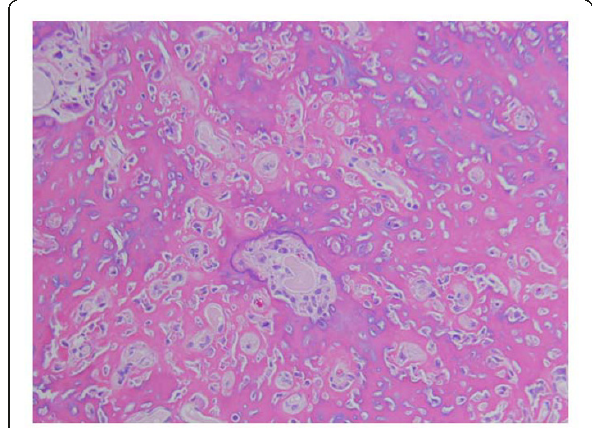
Figure 2 Histological feature of the nidus (×40) . H.E. staining of the lesion revealed that the nidus included anastomosing trabeculae of osteoid and woven bone.